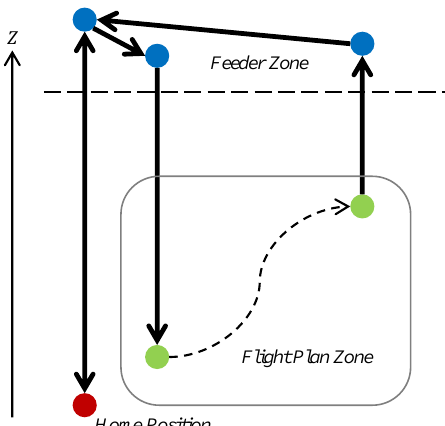
Figure 12. Sketch of the spatial concept of the feeder zone. First and final stations of a mission are horizontally approached at free airspace area.